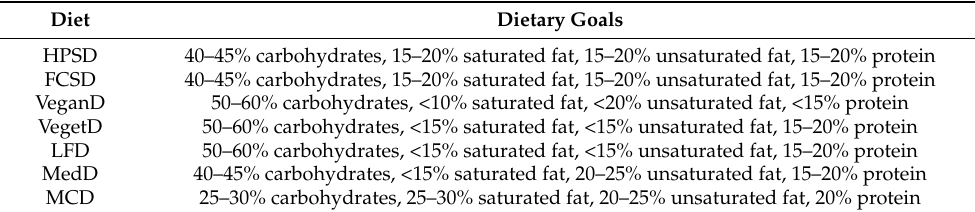
violate these goals anyway. Beverages included 2.15 L for children and 2.6 L for adults